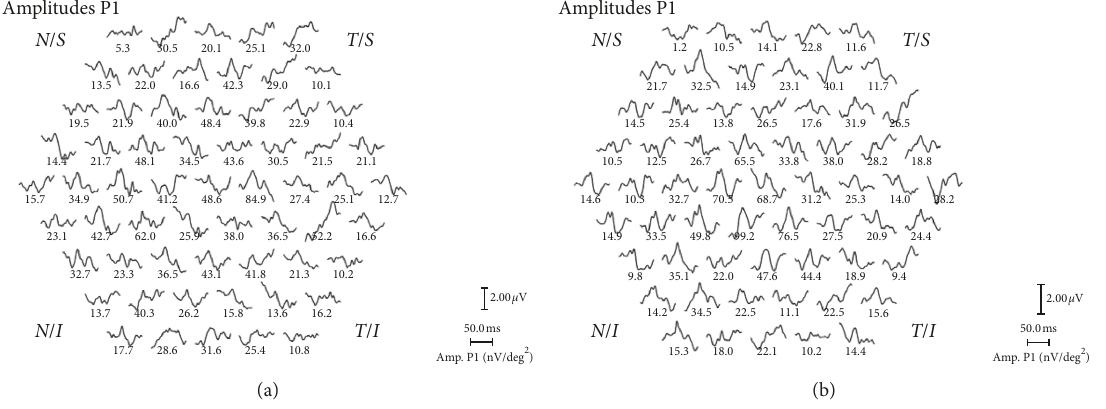
Figure 3: Amplitude of P1 in nV/deg 2 in patient no. 4 in topographic display around fovea, before (a) and after (b) surgery.